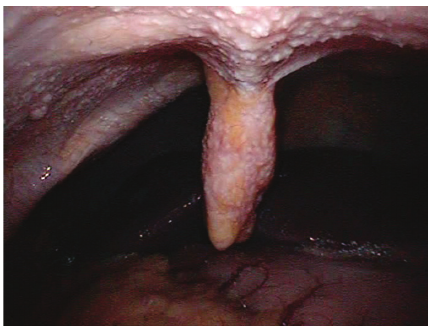
Figure 5: Laparoscopic view demonstrating numerous white tubercles di ff usely covering the parietal peritoneum, suggesting tuberculous peritonitis.